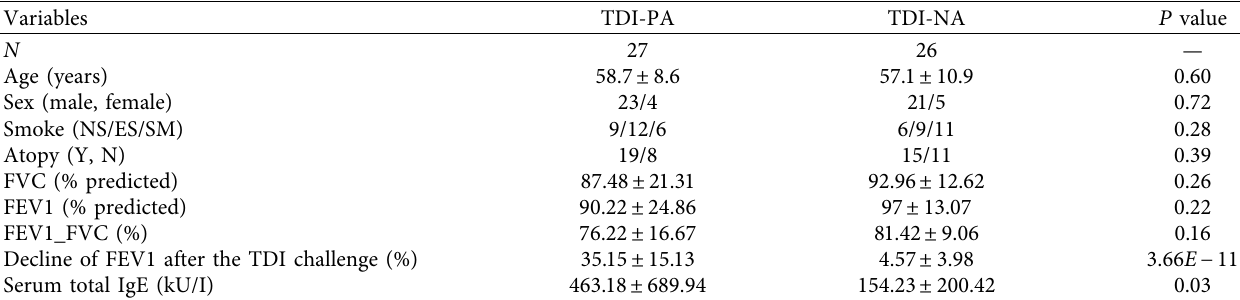
Table 1: Clinical characteristics of the study subjects.